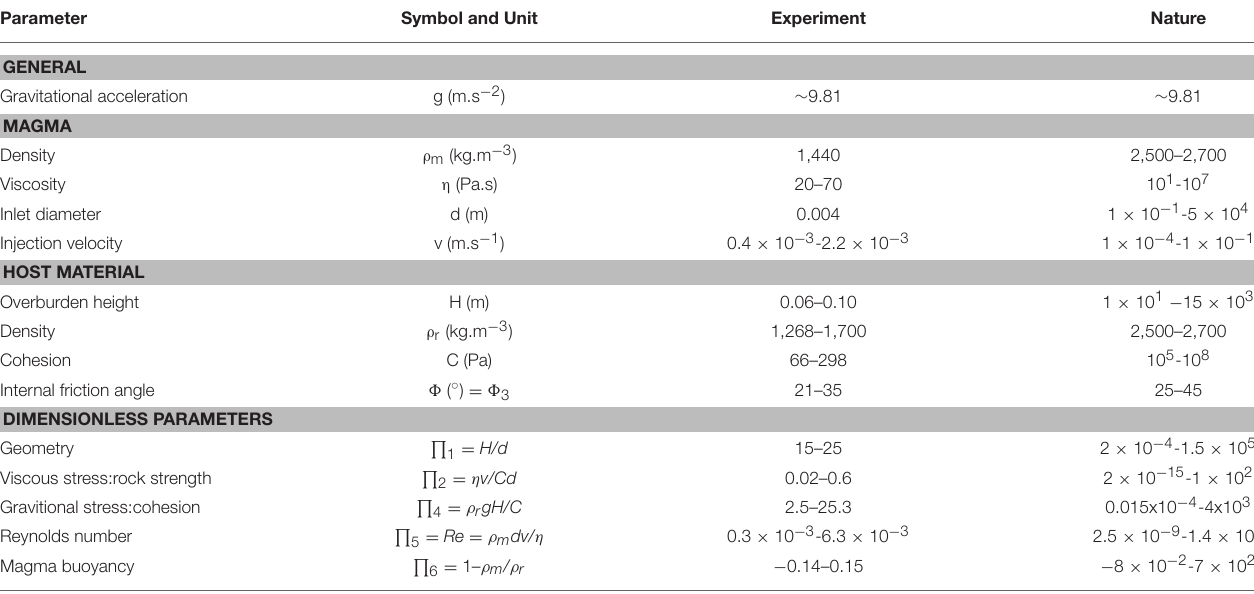
TABLE 1 | Scaling parameters and dimensionless equations used to compare the experiments to nature; natural values come from Schultz (1996), Galland et al. (2014), and Merle (2015).